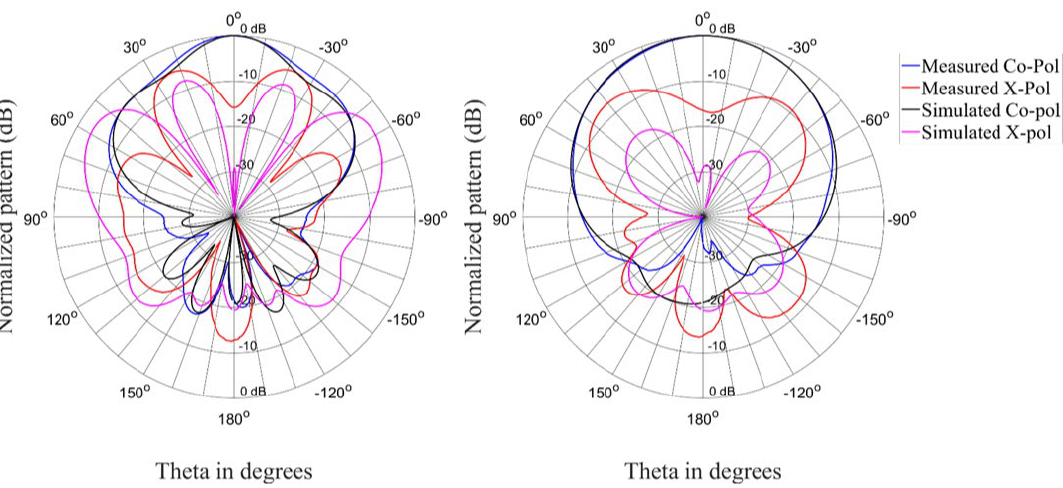
Figure 9. Radiation patterns (Phi = 0° and Phi = 90°) of the antenna in the linear state at 2.35 GHz.